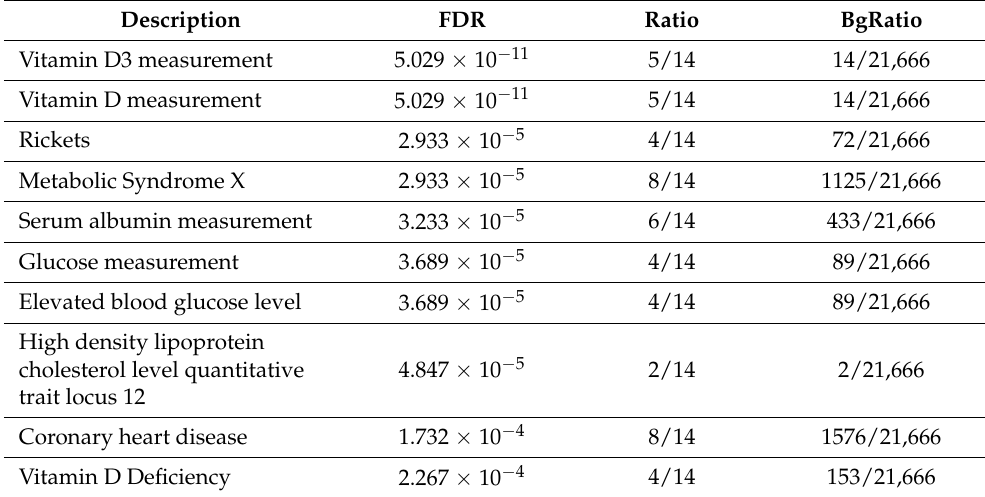
Table 2. Enrichment analysis of the genes associated with a VD deficiency obtained in disgenet2r (R package). The ratio column represents the number of genes from the input list that are associated with the disease. The BgRatio are the number of genes associated with the disease from the length of the universe, in the example, all genes in DisGeNET (the curated or background genes). The p -values resulting from the multiple Fisher tests are corrected for the false discovery rate (FDR) using the Benjamini–Hochberg (BH)